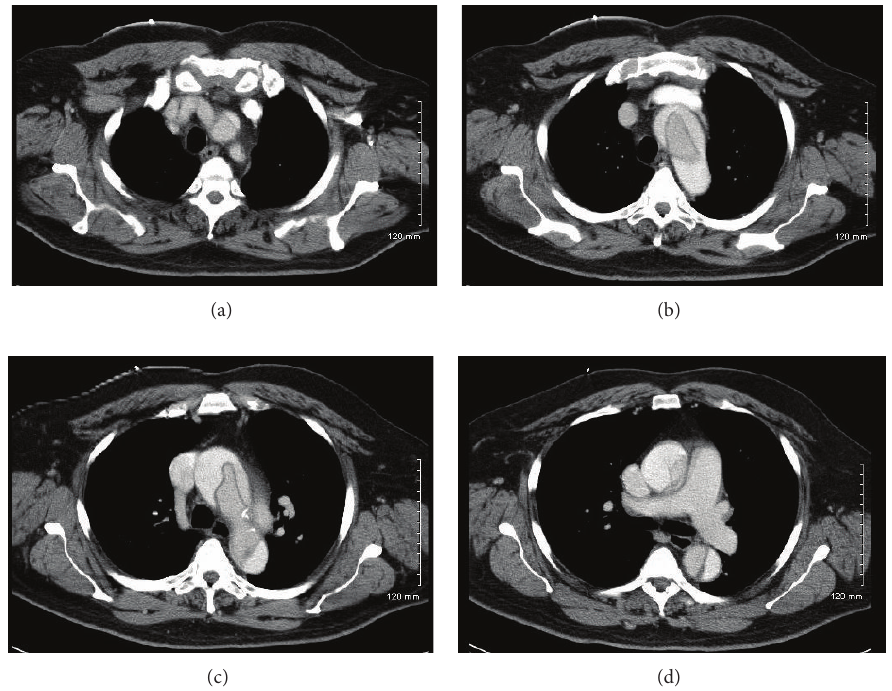
Figure 3: CT scan with contrast showing a thoracic aortic dissection involving the ascending aorta and descending aorta, with an intramural hematoma in the descending aorta. (a)–(d) show coronal sections at different levels.